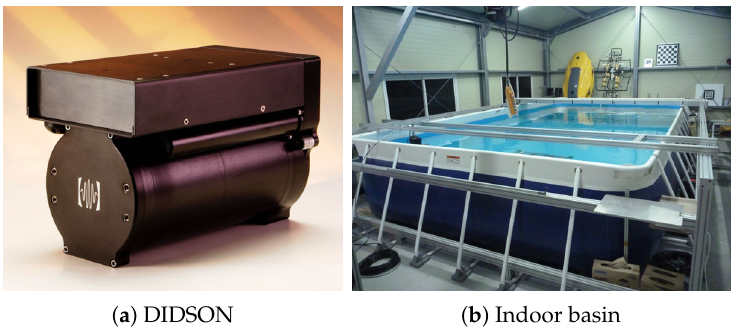
Figure 11. Experimental equipment.